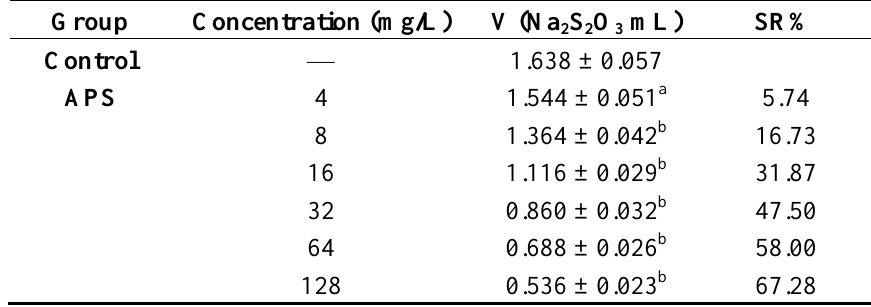
O ( n = 6). Data were expressed as means ± 2 2